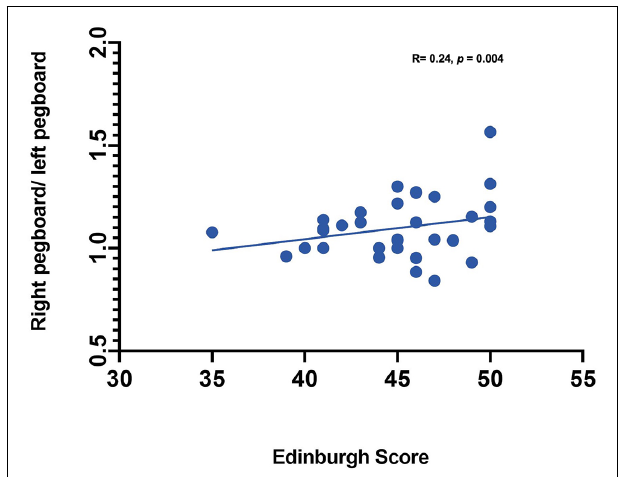
FIGURE 4 | Correlation between handedness measures (Pegboard ratio and Edinburgh score).